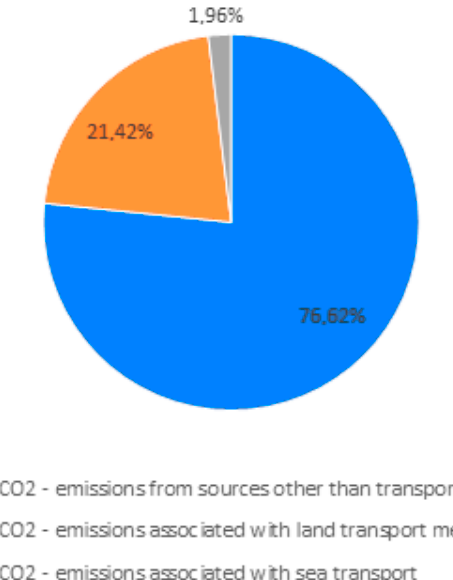
Figure 1. Percentage share of global emissions of CO 2 by source of origin (own compilation according to [1]).